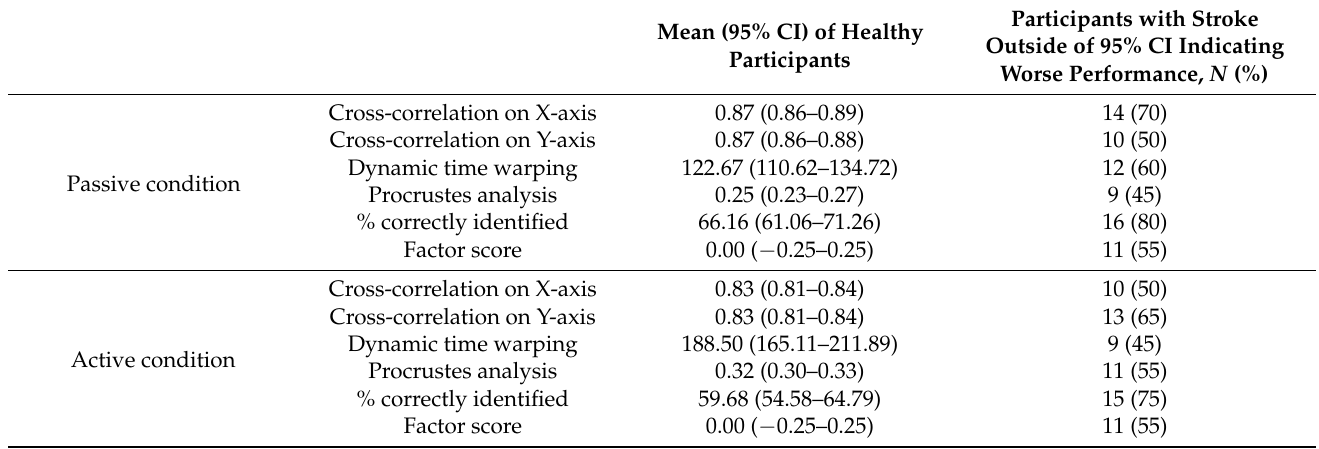
Table 4. Number of participants with stroke showing abnormal performance as compared to healthy participants on the passive and active conditions of the sensory processing